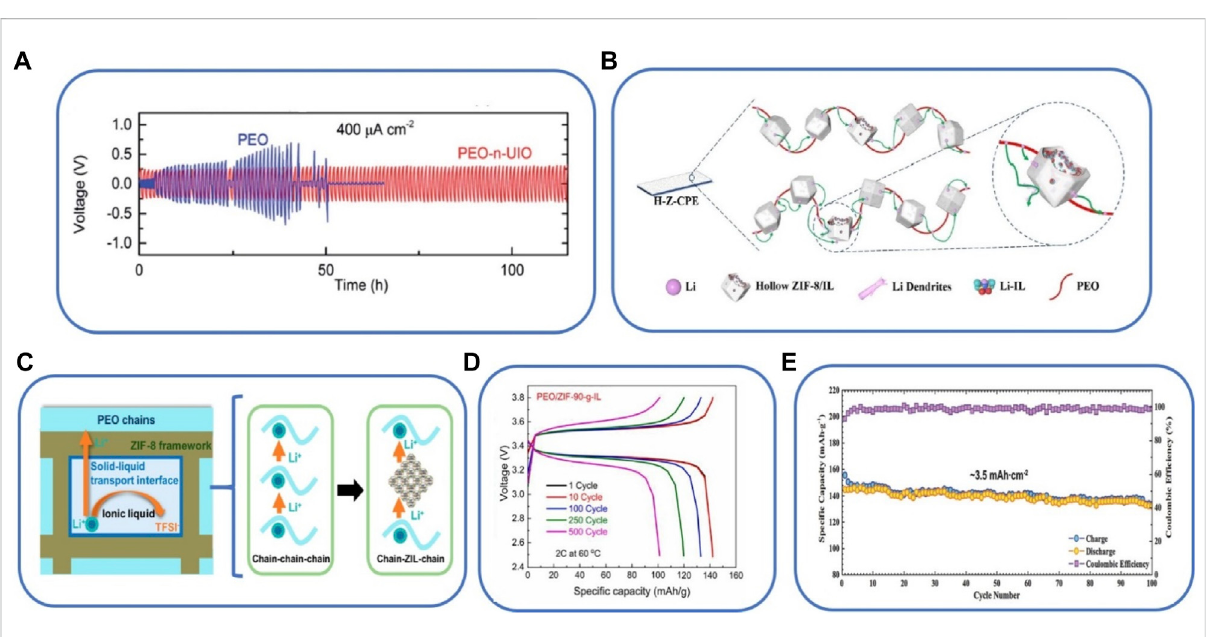
FIGURE 7 (A) Voltage pro fi les as a function of time for a Li cell at 60 ° C (Wu and Guo, 2019a), (B) schematic illustration of a SPE with PEO and ZIF-8/IL (Hu et al., 2022), (C) schematic illustration of the solid − liquid transport interface (Xia et al., 2020), (D) charge/discharge curves of lithium batteries using PEO/ZIF-90-g-IL at 60 ° C and 2C (Lei et al., 2021) and (E) cycling performance and Coulombic ef fi ciency of the SPE based IL@MOF at 0.1 C at room temperature (Wang et al.,